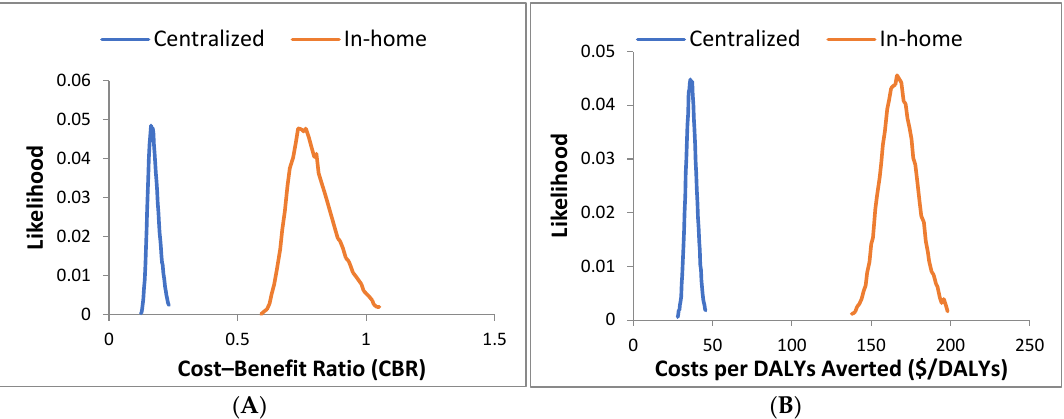
Figure 2. Cost-effectiveness of produced-to-potable configurations as indicated by the ( A ) cost–benefit ratio and ( B ) costs per DALYs averted.